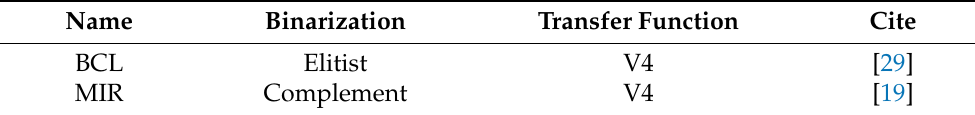
Table 5. Recommended binarization schemes in the literature.